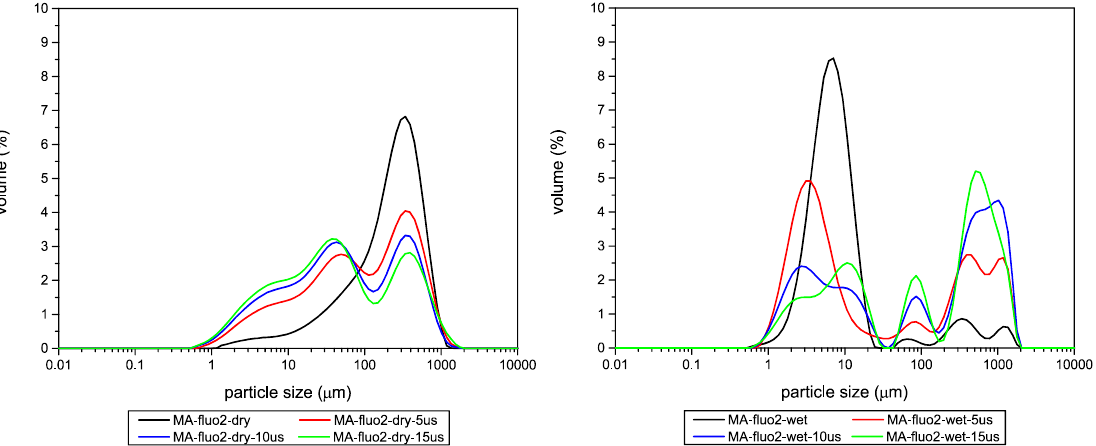
Figure 5. Comparative study of the particle size distribution using dried and wet sample material of sample MA-fluo2.